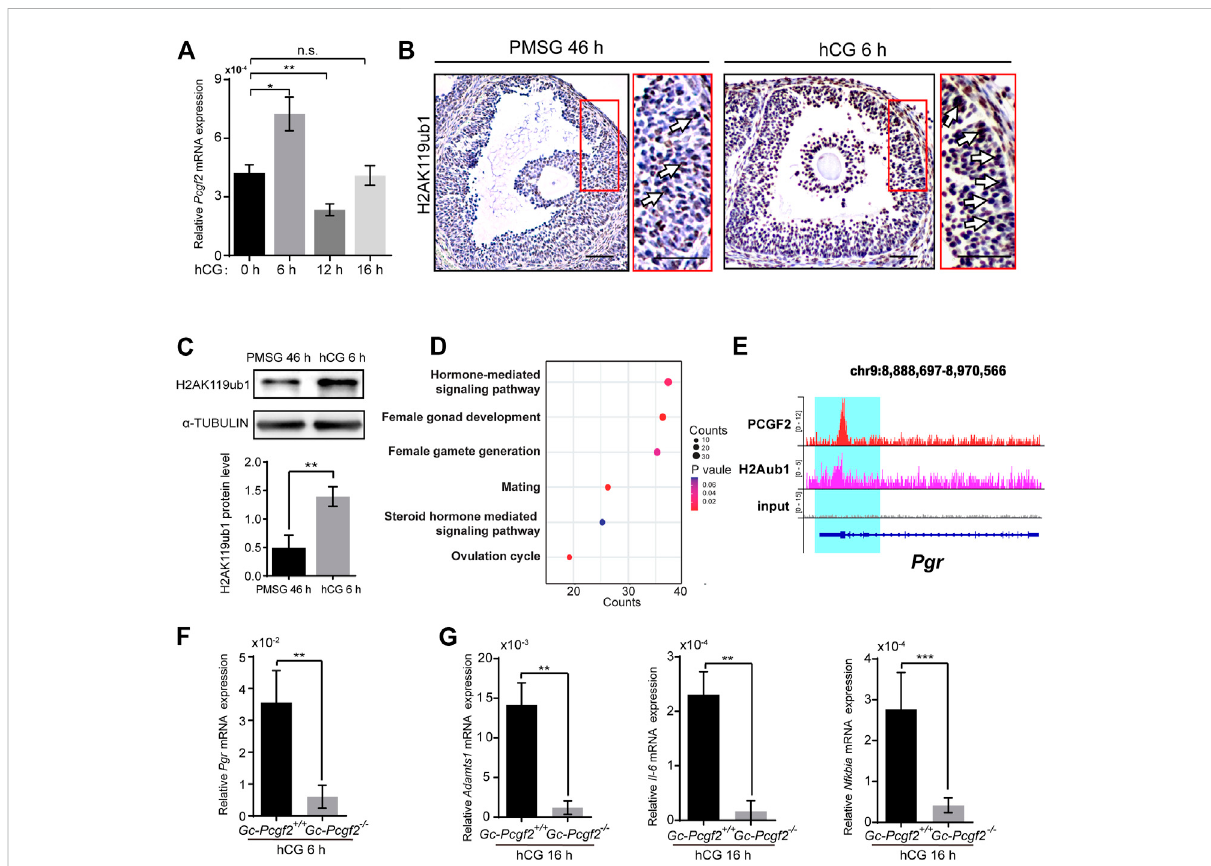
FIGURE 5 PCGF2 binding to thepromoterof progesteronereceptor andmediating theprocess ofovulationin mice. (A) QRT-PCR result showinga Pcgf2 mRNA expression peak at hCG 6 h. (B) The immunohistochemical histological analysis of H2AK119ub1 showing an increasing signal of H2AK119ub1 (arrows) in the GCs of preovulatory follicles at hCG 6 h compared with at PMSG 46 h. Scale bars: 50 µm. (C) Quantitative analysis of western blot showing a signi fi cantly increasing accumulation level of H2AK119ub1 in GCs at hCG 6 h compared with at PMSG 46 h. (D) The GO analysis of PCGF2 target genes showing that the target genes were associated with female fertility, including ovulation and hormone related pathways. (E) Genomic snapshot ofthe indicated ChIP-seq pro fi les of PCGF2 and H2Aub1 (H2AK119ub1) atgene loci of Pgr . (F) The statisticalanalysisof theQRT- PCR result showing asharply decreasingof Pgr in GCs of GC-Pcgf2 − / − athCG 6 hcompared with that in controls ( n = 3per group). (G) The statistical analysis of QRT-PCR results showing signi fi cantly decreasing the mRNA levels of Adamts1 , Il-6 , and Nf κ bia in GCs of GC-Pcgf2 − / − at hCG 16 h. The experiments were repeated at least three times. The data in (A,C,F,G) represent the results (mean ± SD) of the biological triplicate experiments. n.s. p > 0.05, * p < 0.05, ** p < 0.01, and *** p < 0.001 by two-tailed unpaired Student ’ s t